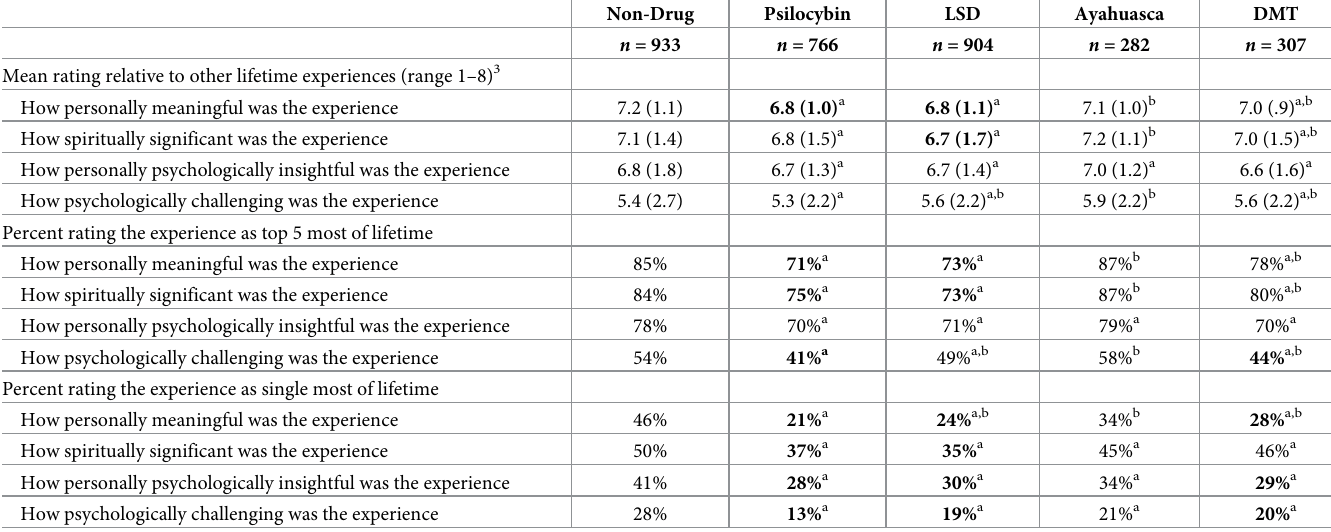
Table 10. Comparison of experience relative to other lifetime experiences among the Non-Drug, Psilocybin, LSD, Ayahuasca, and DMT groups 1,2 .